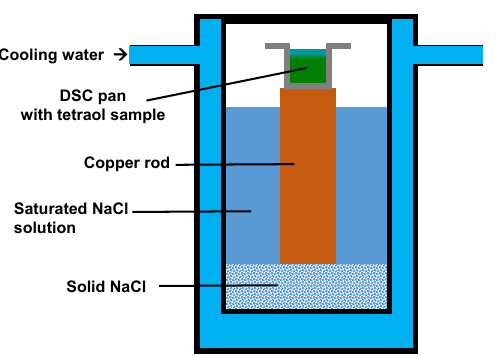
Figure 6. Sketch of the environmental chamber used in this study to expose rac -(2 R ,3 R) -tetraol to an atmosphere with 75% RH. The sample is placed on top of a copper rod immersed in a saturated aqueous NaCl solution inside a temperature-controlled chamber set to 0.5 ◦ C.